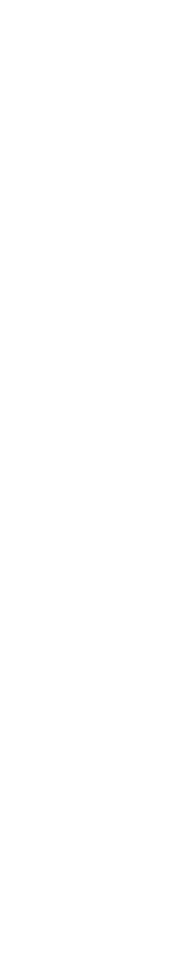
Figure 3. Age of death in Australia 2002–2006, by gender and ethnicity. Source: ABS and AIHW 2008 [3].